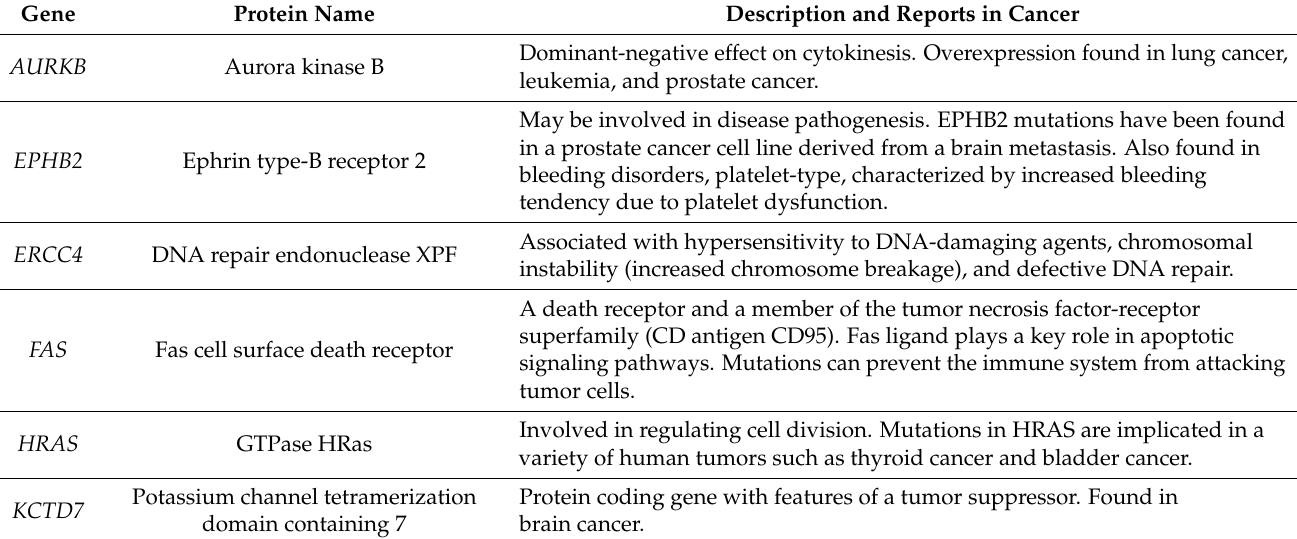
Figure 10. Venn diagram showing cancer-specific proteins identified in this study for each subtype of EV derived from pleural mesothelioma cell lines. Data obtained from four biological replicates. Table 7. Details of proteins that have been reported in other cancers and that were exclusively found in the 10 K pellets of all five mesothelioma cell lines while being absent in the control cell